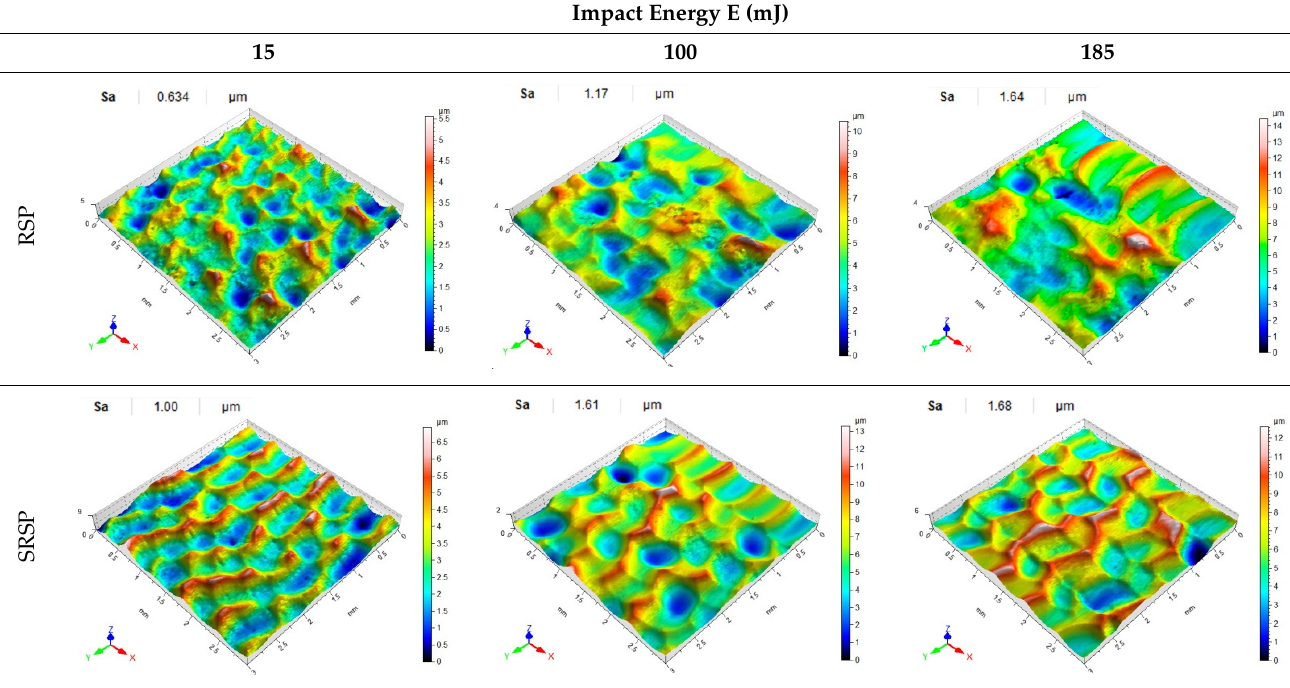
Table 8. Effect of impact energy on the Sa roughness parameter and surface topography (ball diameter D = 10 mm, distance between dimples x = 0.3 mm).